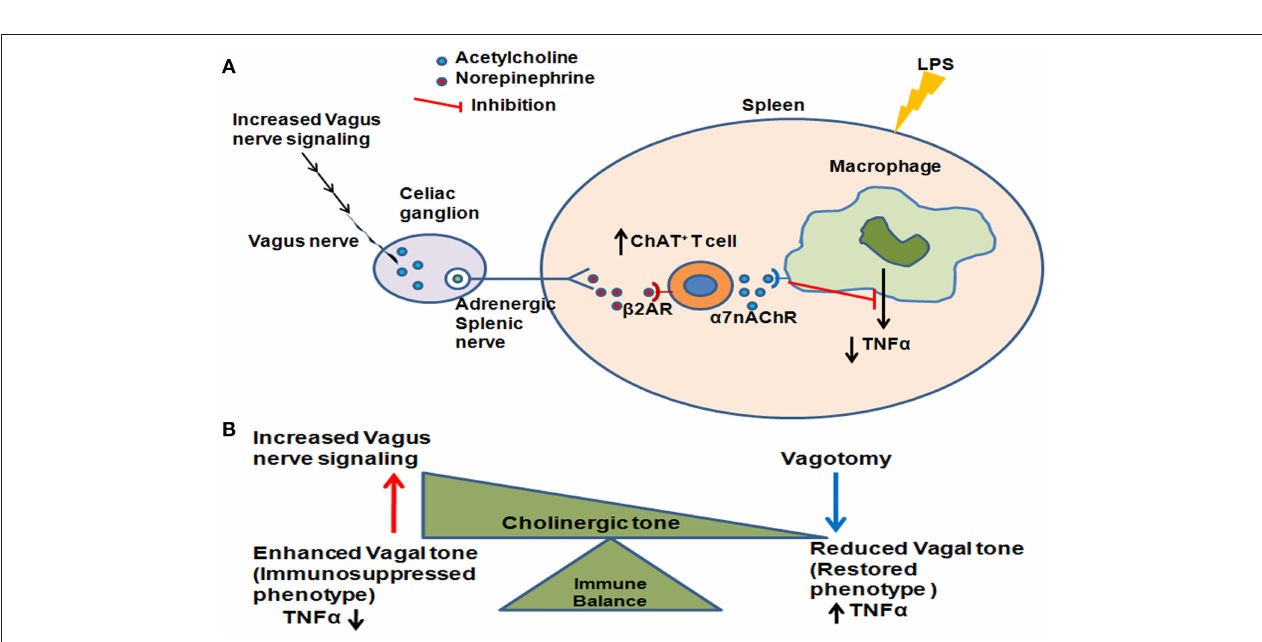
FIGURE 5 | Enhanced vagus nerve signaling effects on LPS-induced TNF α in CLP-survivors. (A) Increased vagus nerve signaling leads to activation of the higher number of acetylcholine-producing T cells (ChAT + T cells) in the spleen. Subsequent activation of α 7 nicotinic acetylcholine receptor ( α 7AchR) on monocytes/macrophages leads to an inability to further suppress LPS-induced TNF α . (B) The cholinergic tone determines the immune balance, shifting between enhanced vagus nerve activation leading to an immunosuppressed phenotype and decreased vagus nerve activation leading to restored